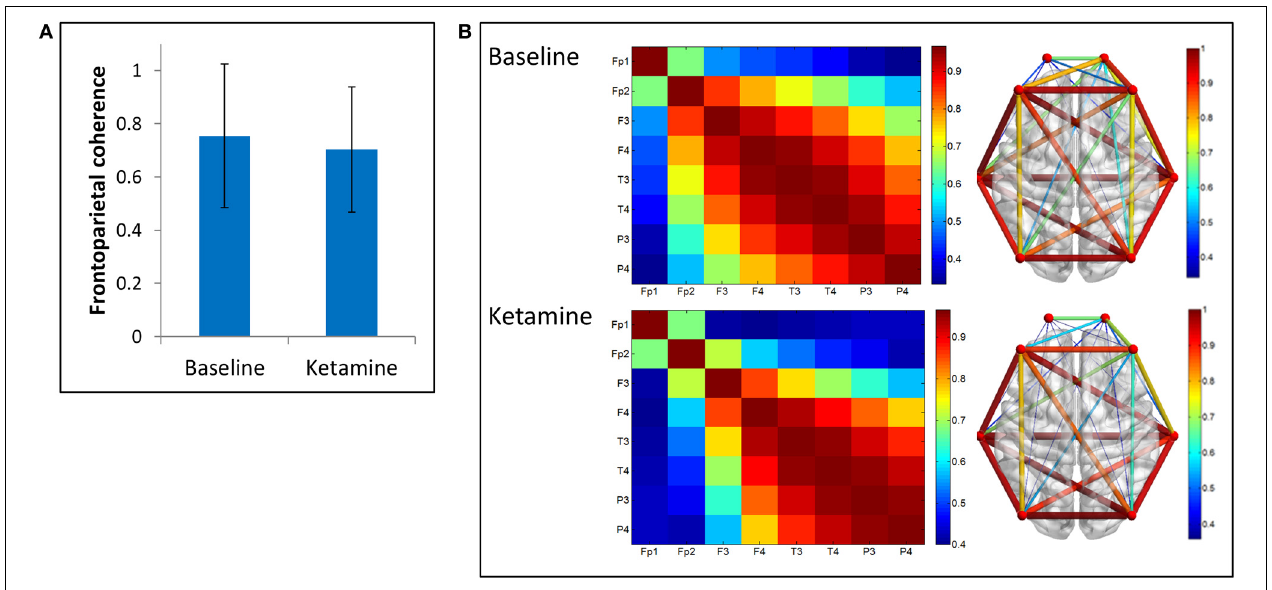
FIGURE 3 | Coherence analysis. (A) Average frontoparietal coherence across 28 participants in baseline resting and ketamine-induced unconscious states (error bars indicate standard deviation). No significant differences are observed in coherence between conditions. (B) Average coherence across all